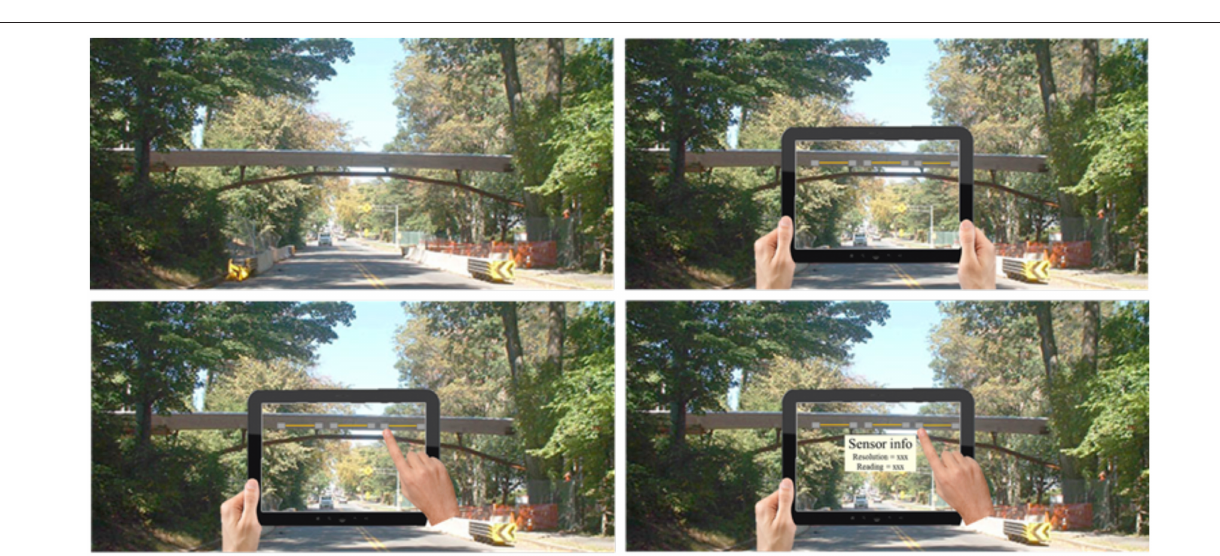
FIGURE 2 | Conceptual design for augmented reality application. Each panel indicates a step in a user’s process: (1) view structure on site, (2) view existing damages or sensors in the context of the structure, (3) interact with existing annotations, (4) visualize existing data and metadata for a